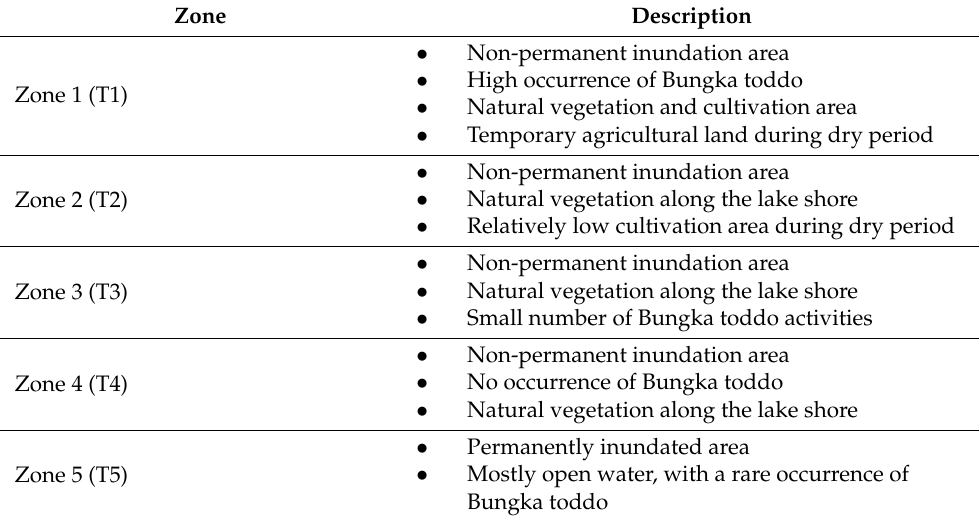
Table 1. Descriptions of each sampling location in Lake Tempe. Note: Bungka toddo is a local fishing technique using emerged aquatic macrophyte colonies as fish attractors; when water levels start to recede, bamboo fences are installed around the macrophyte colonies to trap fish. Zone